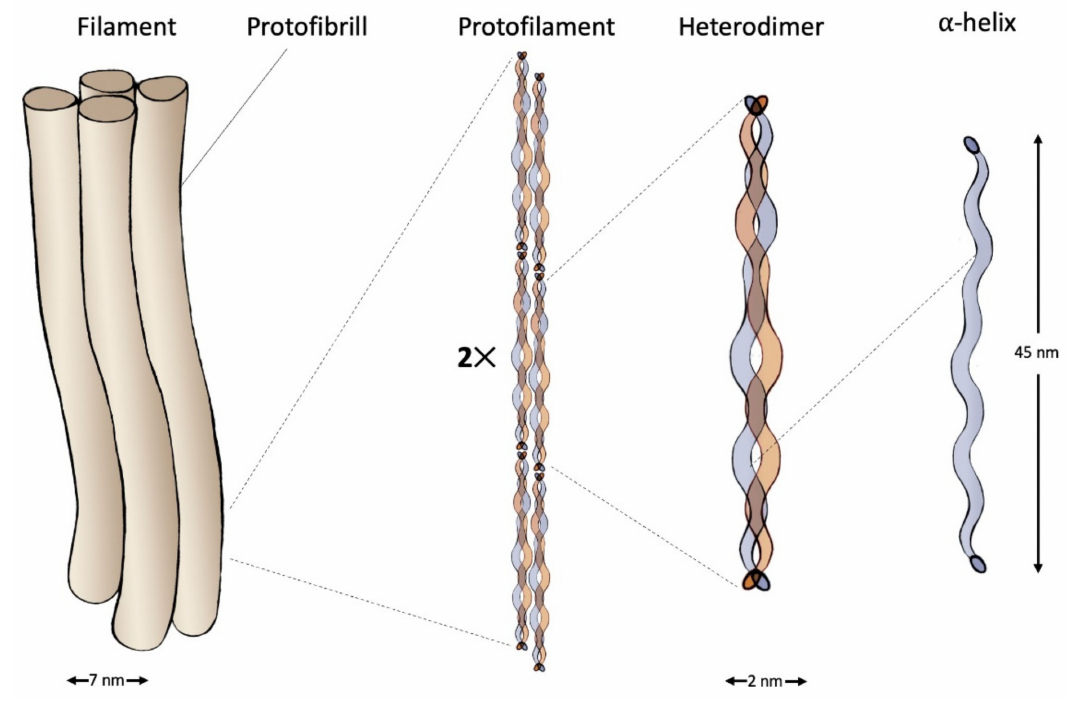
Figure 2. Structure of an intermediate filament composed of